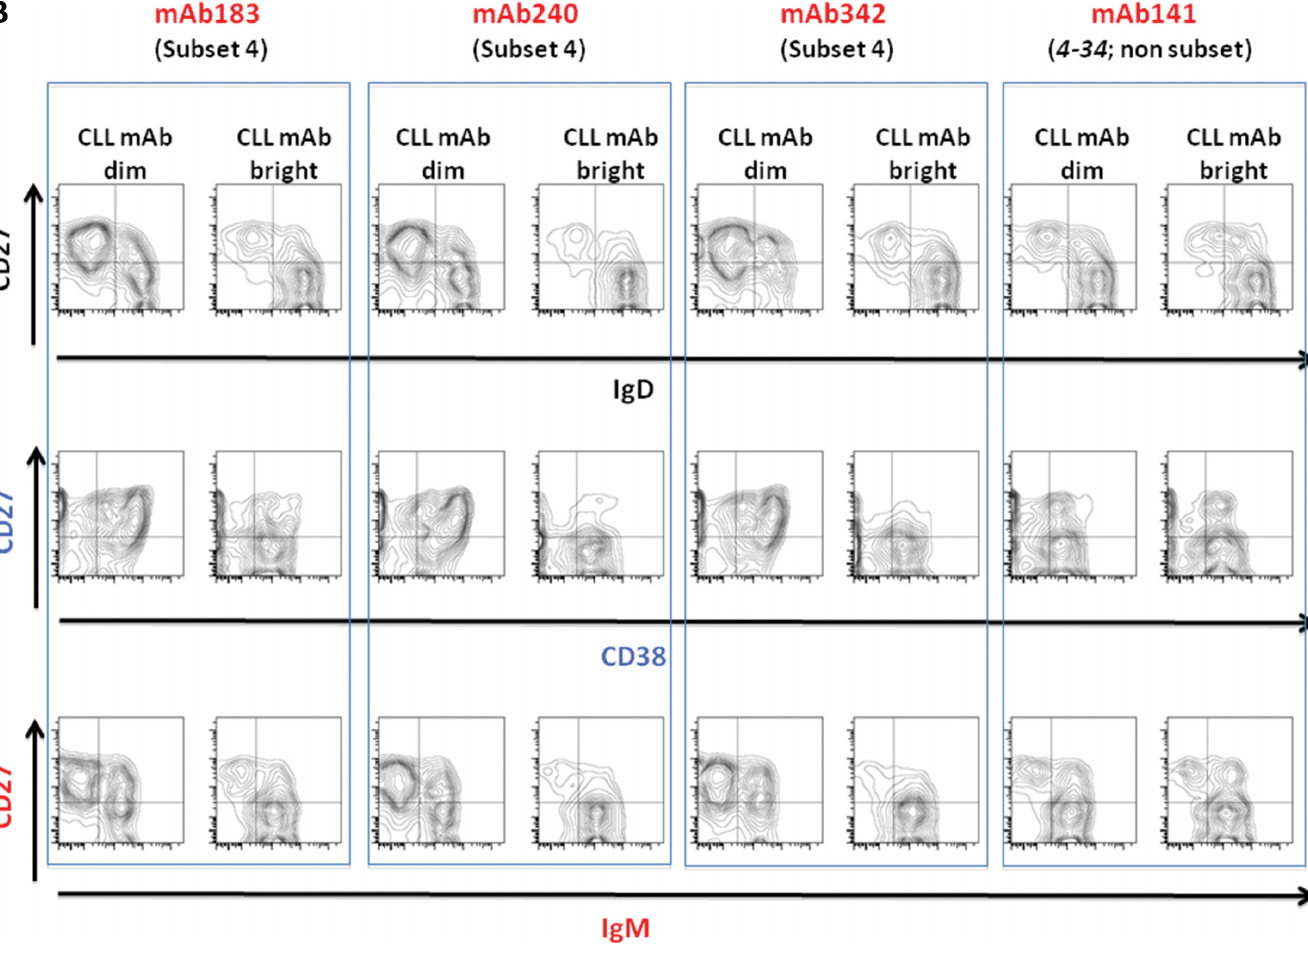
their respective target carbohydrate antigens: the anti-i with pLNnH and LNnO, the anti-I with I-octa and Fc10.2 with pLNH. These findings validate the structures of the poly LacNac sequences displayed on the